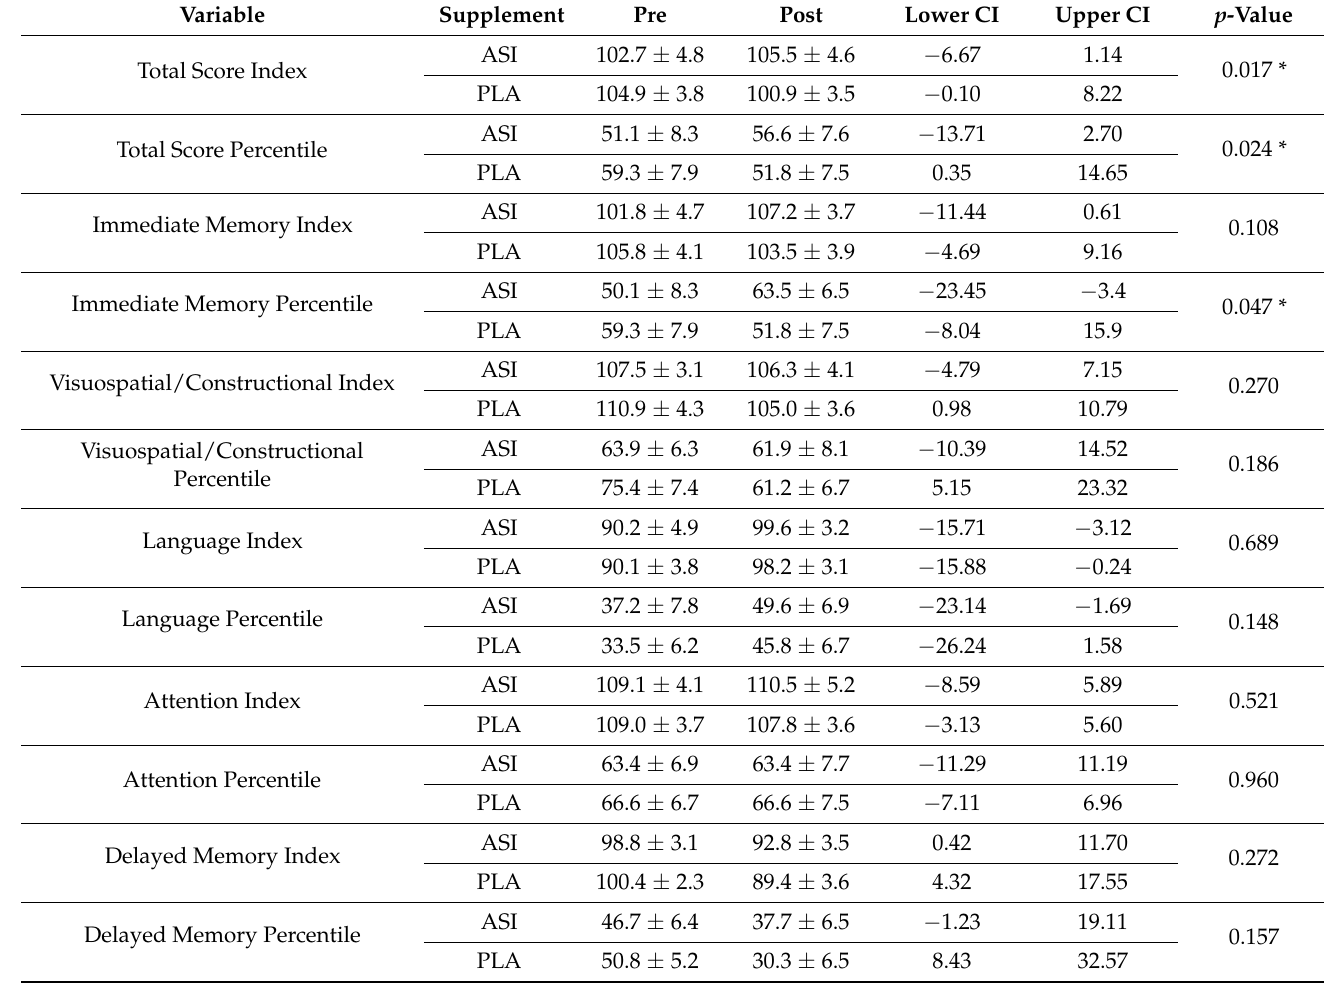
Table 1. RBANS data.